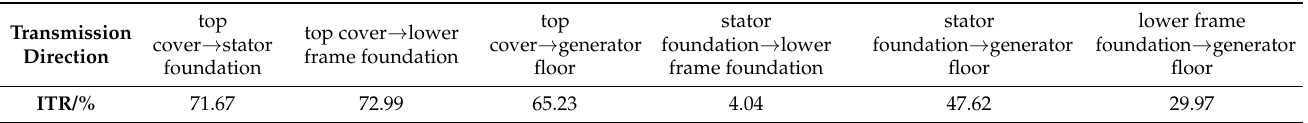
Table 6. Information-transmission rate between measurement points of condition